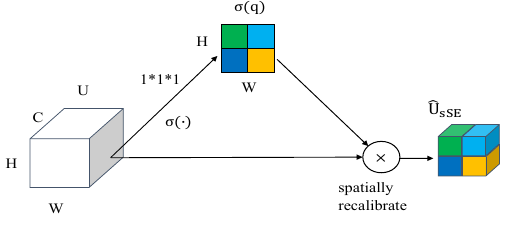
Figure 4. The structure of sSE.